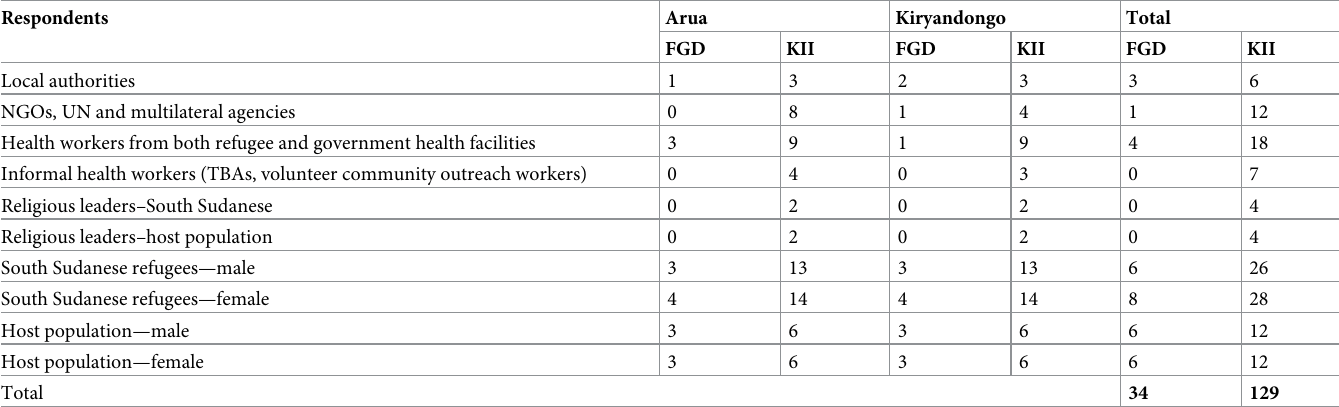
Table 2. Number of focus group discussion and key informant interviews by respondent